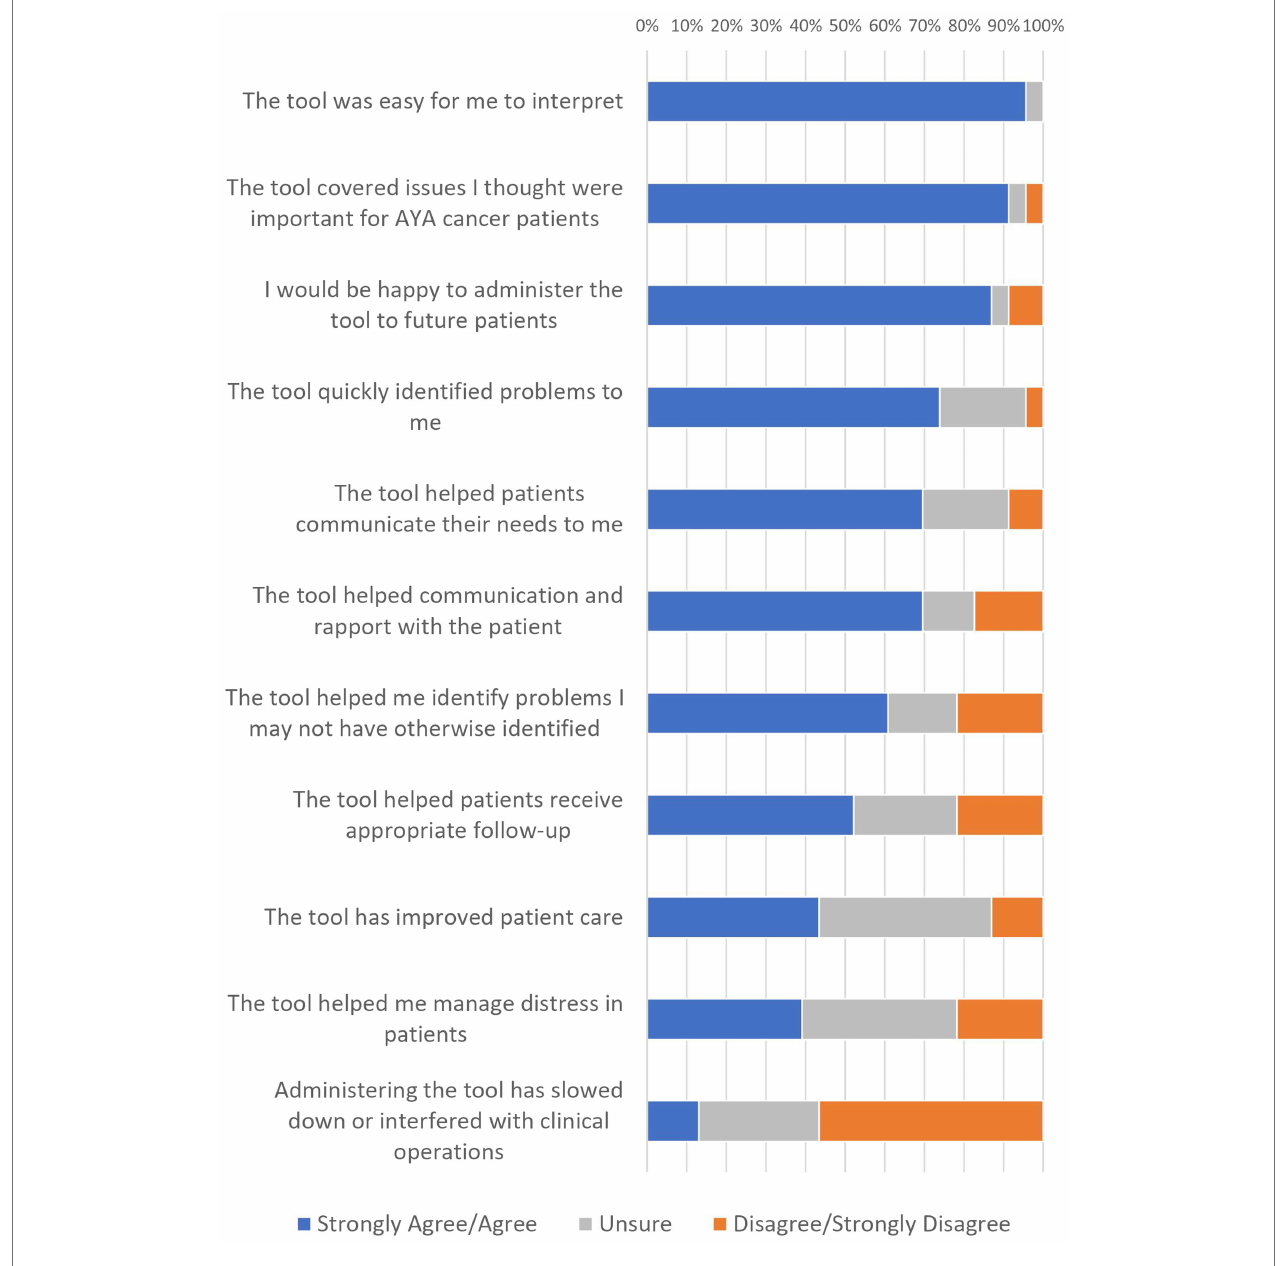
FIGURE 3 | HCP ratings of the clinical utility of the